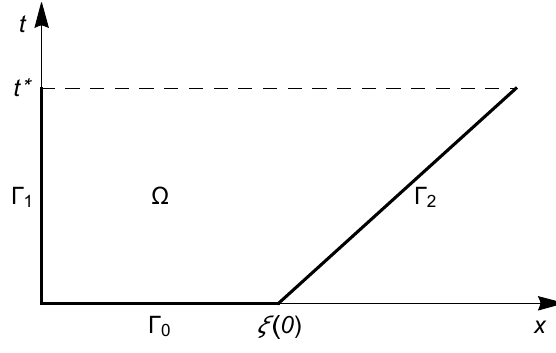
Figure 1. The domain of the considered